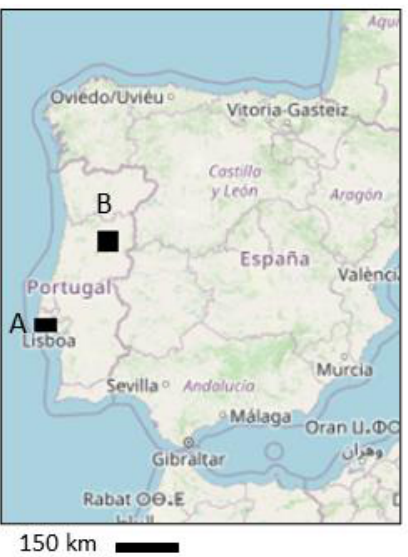
Figure 1. Study area A: Lisbon metropolitan area (LXMA); and Study Area B: Serra da Estrela National Park (SENP) in Portugal, Iberian Peninsula, SW Europe. OpenStreetMap as base map.